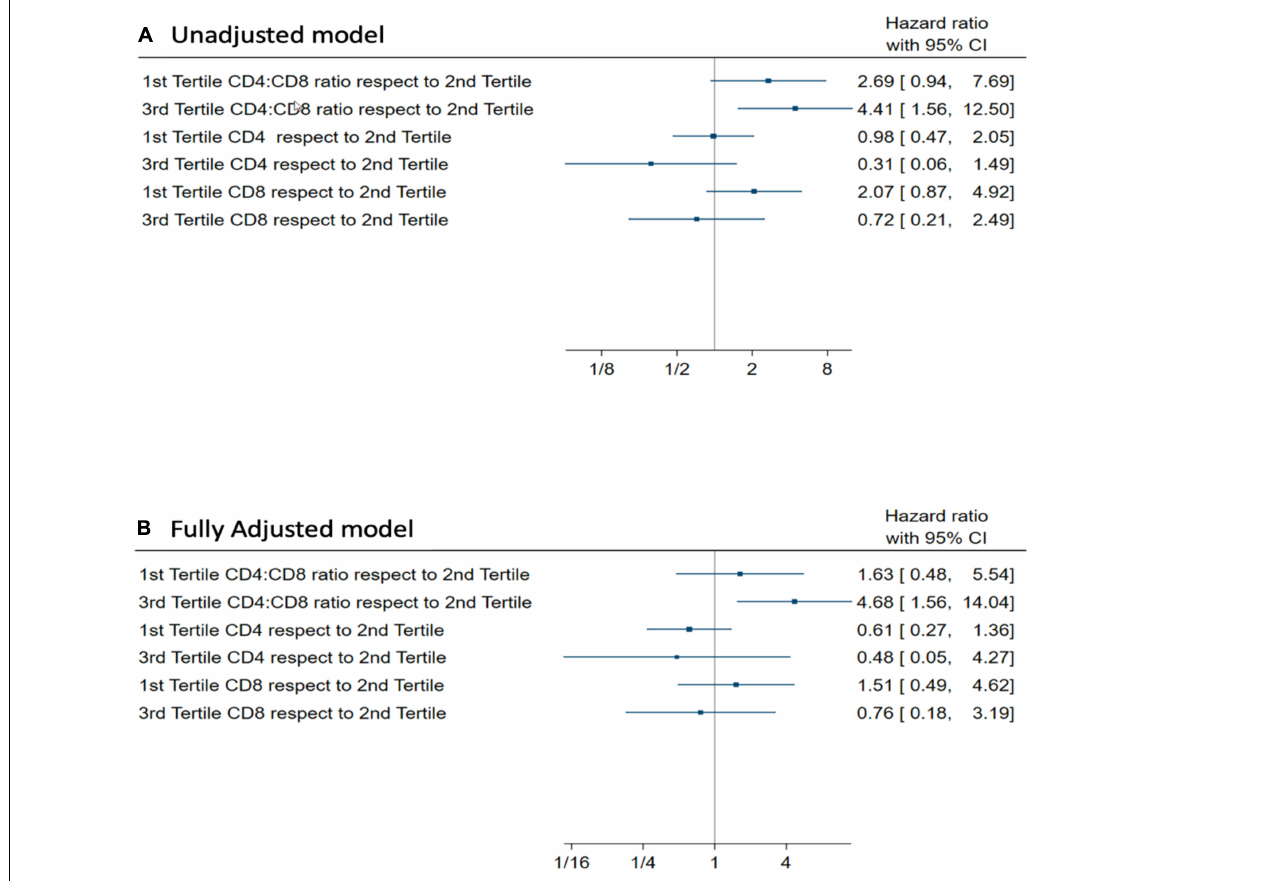
FIGURE 1 | (A) Unadjusted Hazard ratio for In-hospital mortality (Cox Proportional Hazards model) for CD4/CD8 ratio tertiles, CD4 tertiles, and CD8 tertiles. (B) Adjusted Hazard ratio by age, sex, comorbidity, and severity for in-hospital mortality (Cox Proportional Hazards model) for CD4/CD8 ratio tertiles, CD4 tertiles, and CD8